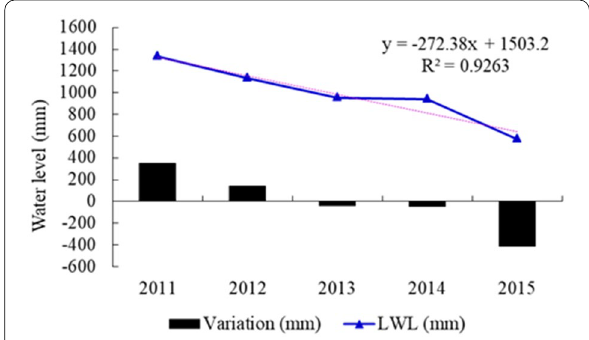
Fig. 7 The mean annual water level (free water surface gauge readings) and level variations (mean value deviations from each observation) from 2011 to